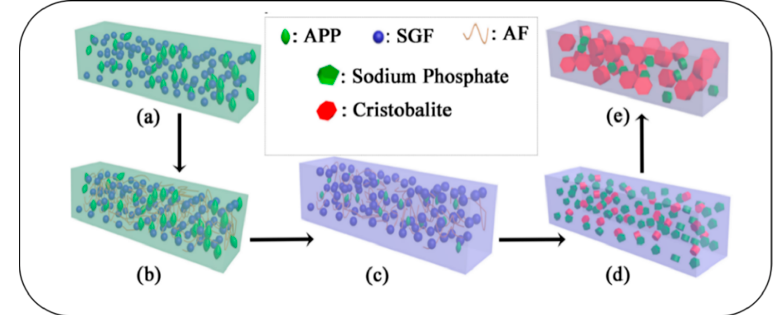
Figure 11. Schematic presentation of the mechanism of self-supporting: ( a ) ceramifiable EPDM composite without AF, ( b ) EPDM/AF composite, ( c ) fired at below 600 °C, ( d ) fired at a range of 600–800 °C, and ( e ) fired at above 800 °C.